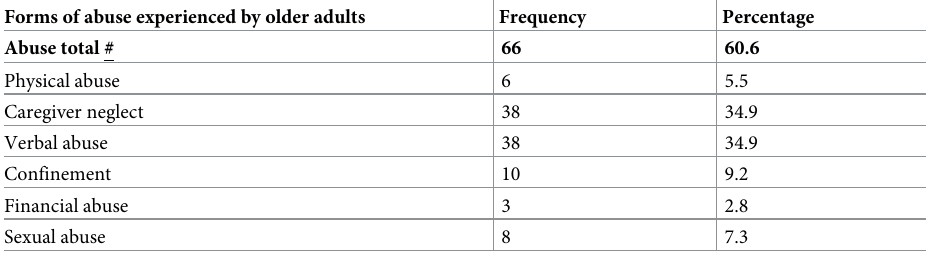
Table 5. Forms of abuse experienced by older adults before coming to old age home (n = 109). Forms of abuse experienced by older